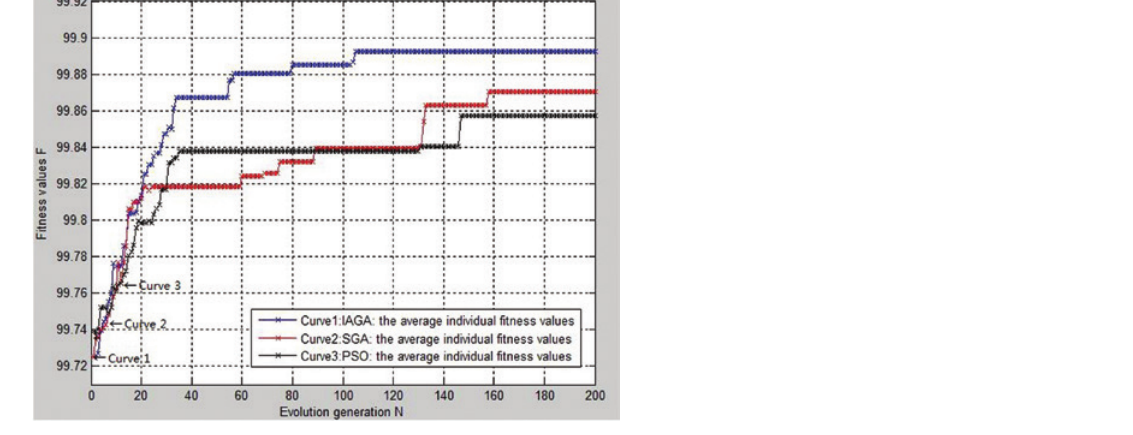
Figure 2: Comparative Running Results of the IAGA, SGA, and PSO.